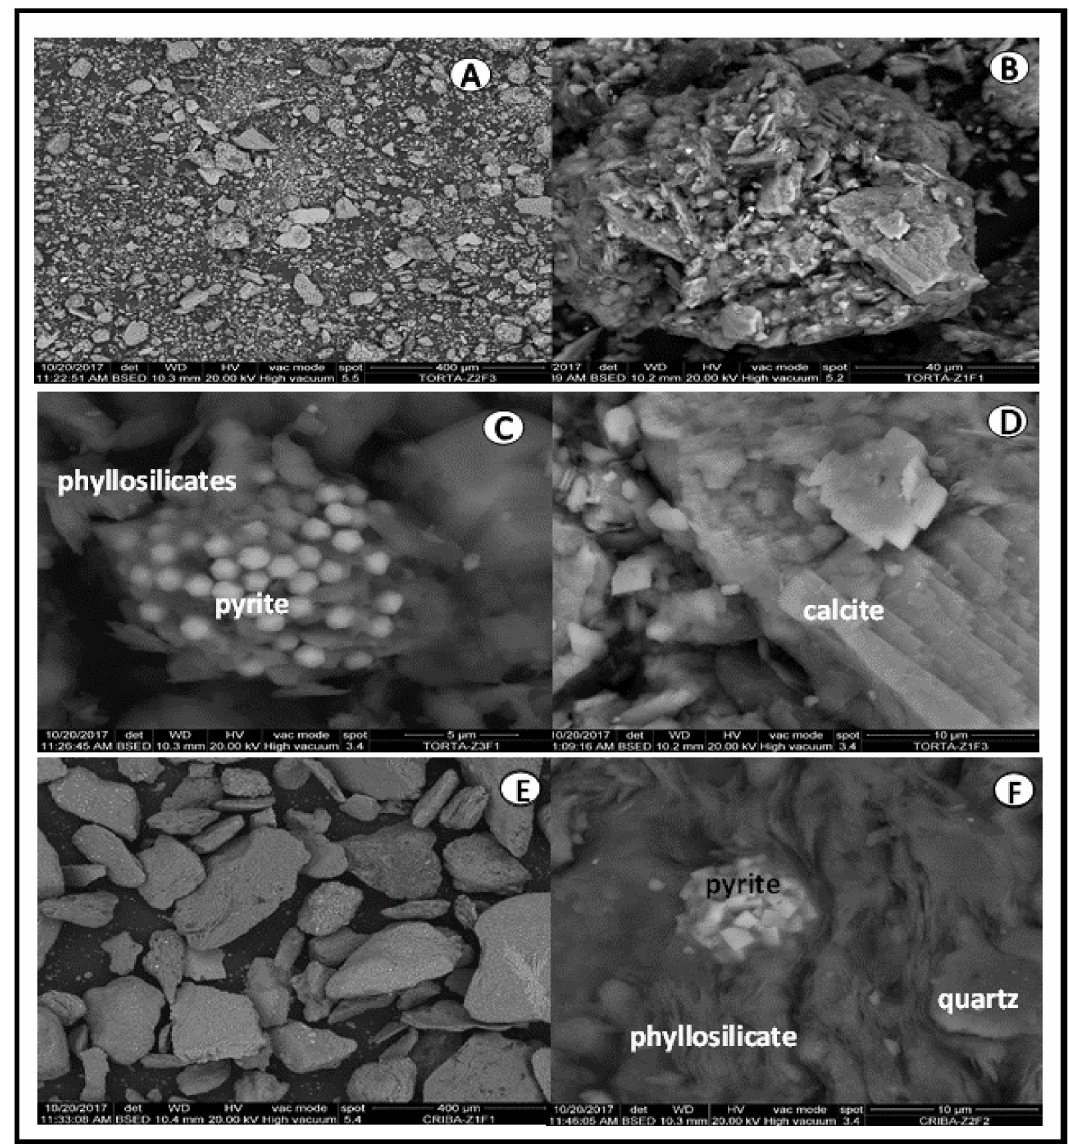
Figure 4. Scanning electron microscopy (SEM) analysis: ( A ) aggregates of variable size in very fine-grade raw tailings sample; ( B ) porous aggregates in very fine–grade sample; ( C ) sheets of phyllosilicates with cavities containing idiomorphic pyrite crystals in the very fine–grade sample; ( D ) rhombohedral exfoliation calcite crystals in very fine–grade sample; ( E ) homogeneous size of aggregates in fine-grade sample; ( F ) phyllosilicates, quartz, and pyrite crystals in fine-grade